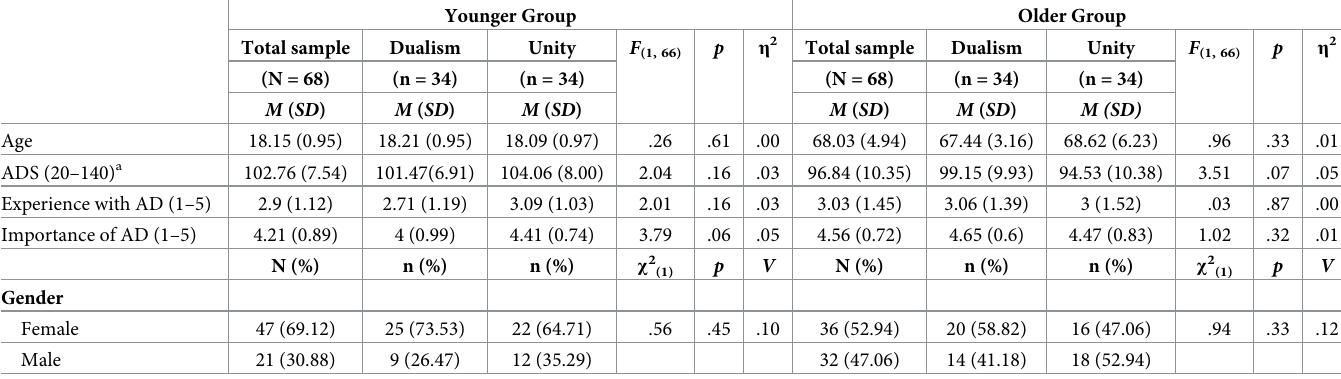
Table 1. Sample characteristics, outcomes and study